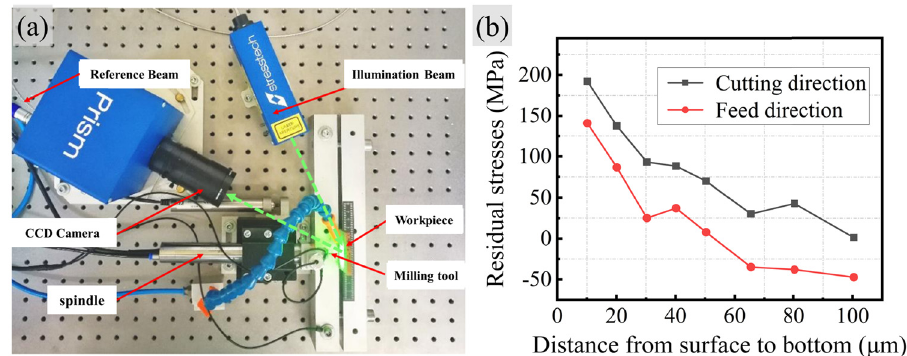
Figure 9: ( a ) ESPI setup for the residual stress measurement and ( b ) measured results of residual stresses in the cutting and feed